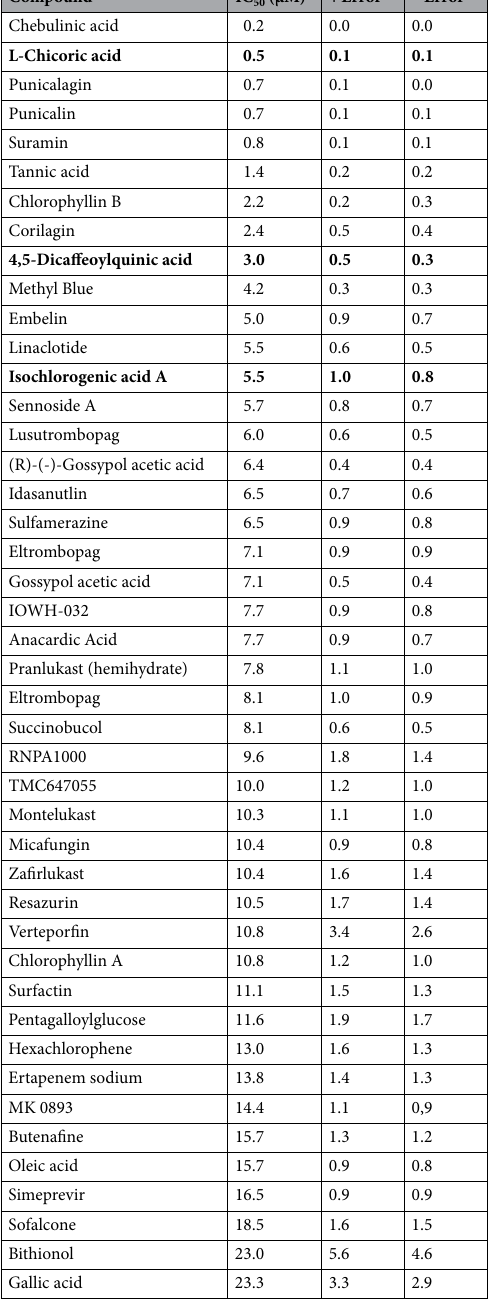
Table 1. List of the 44 confirmed hit molecules retrieved from the HTS campaign as potential N-protein ligands. Compounds are ranked by their IC 50 values for blocking the N protein-RNA1 interaction. Phenyl propanoids with dicaffeoyl motif are highlighted in bold. *Reported errors are deviation from mean value for upper (+ Error) and lower (− Error) limits of 95% confidence